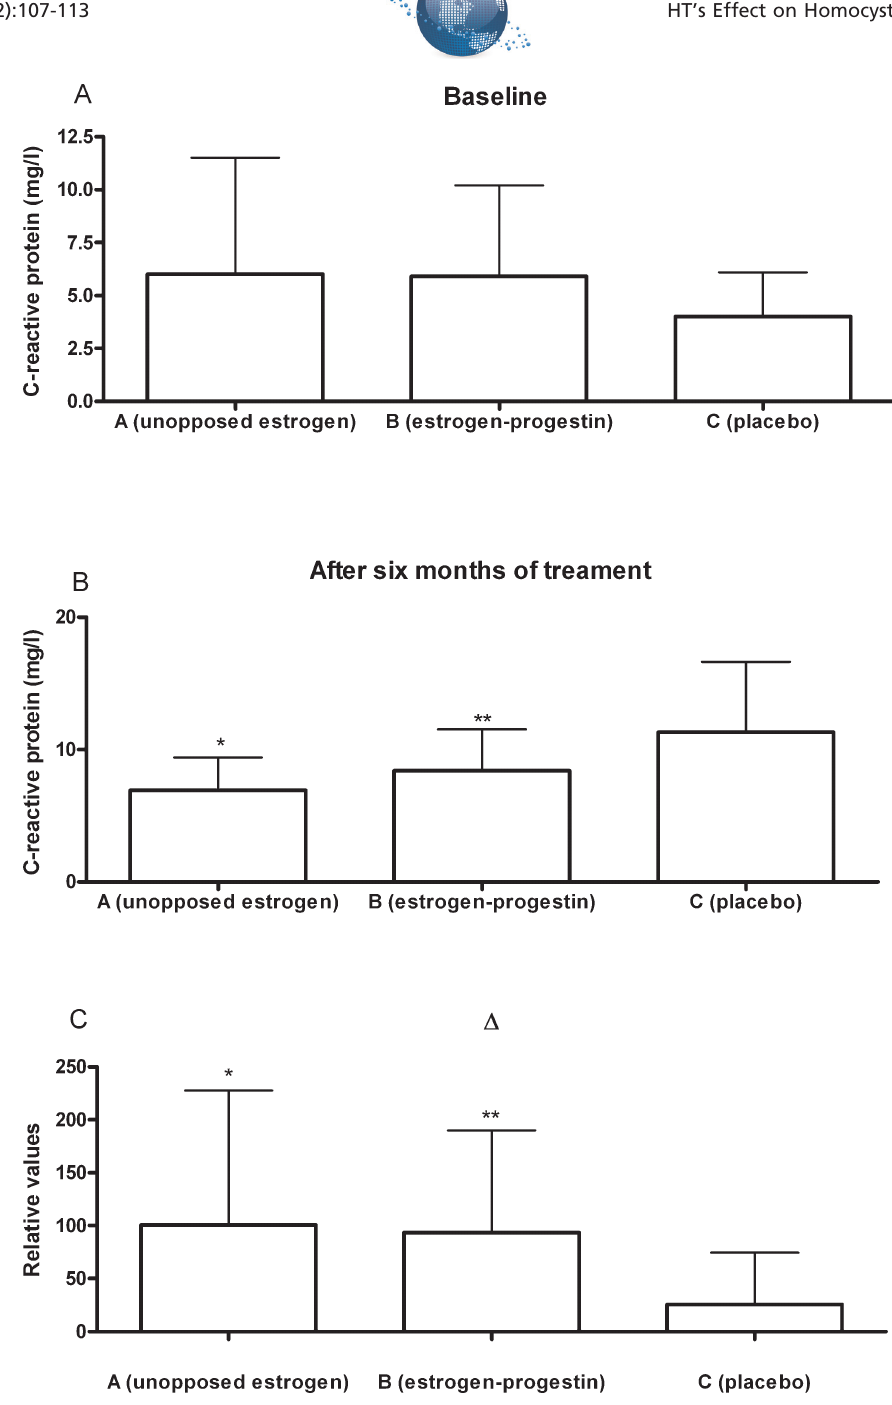
Figure 2 - Graphical representation of C-reactive protein values during the study: a) baseline; b) after six months of treatment; c) delta {( D = [(value after treatment - baseline value)/baseline value * 100]}. * p , 0.01 compared with the other groups; ** p , 0.01 compared with the study found a similar difference between the two estrogen regimens (unopposed and combined) (26).